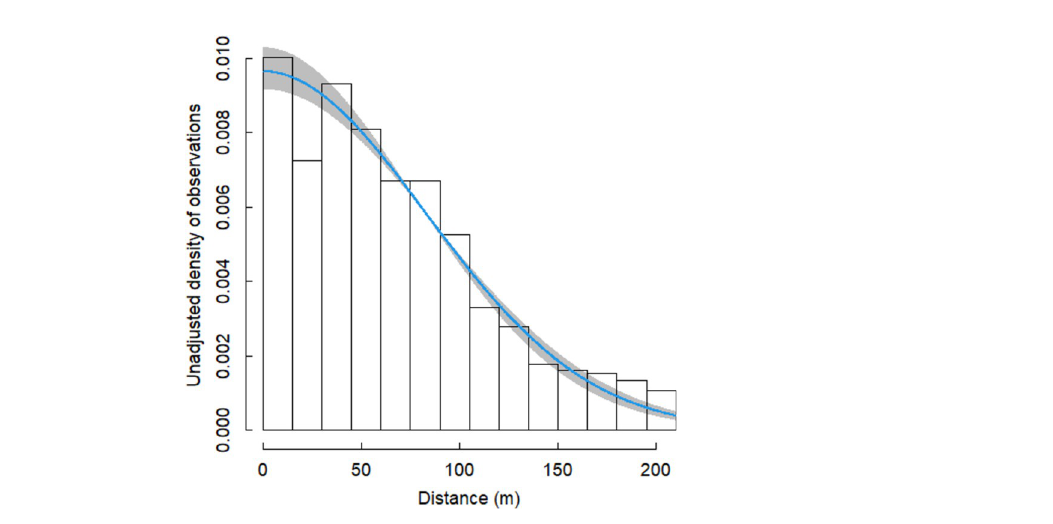
Fig 2. Murrelet detection function. Unadjusted density of marbled murrelet groups with distance from the transect centerline across all 2-month survey windows and years.